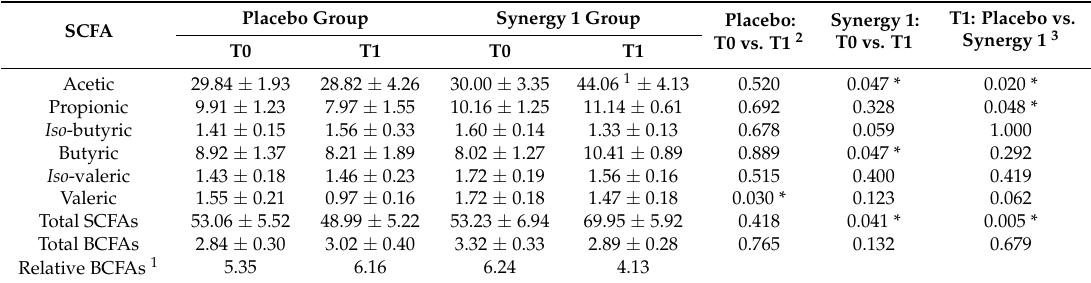
Table 3. Short chain fatty acids (SCFAs) concentration in faecal samples before (T0) and after (T1) the intervention, expressed by means ± SEM and by µ mol/g of faeces. Placebo Group Synergy 1 Group Placebo: SCFA